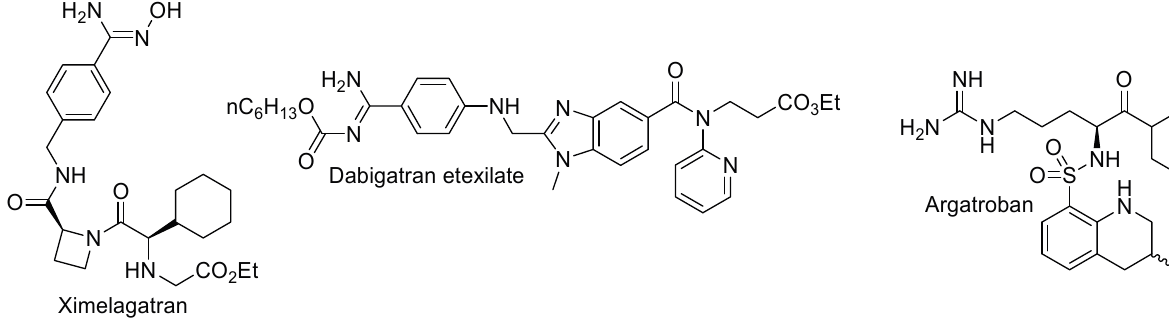
Figure 1. The chemical structures of three small molecule thrombin